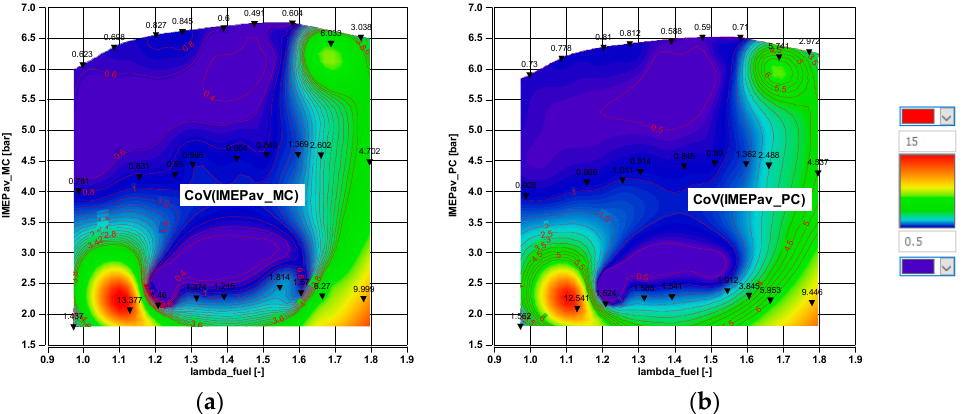
Figure 14. Maps of engine operation variability relative to the fuel mixture proportions: ( a ) in the main chamber; ( b ) in the prechamber.